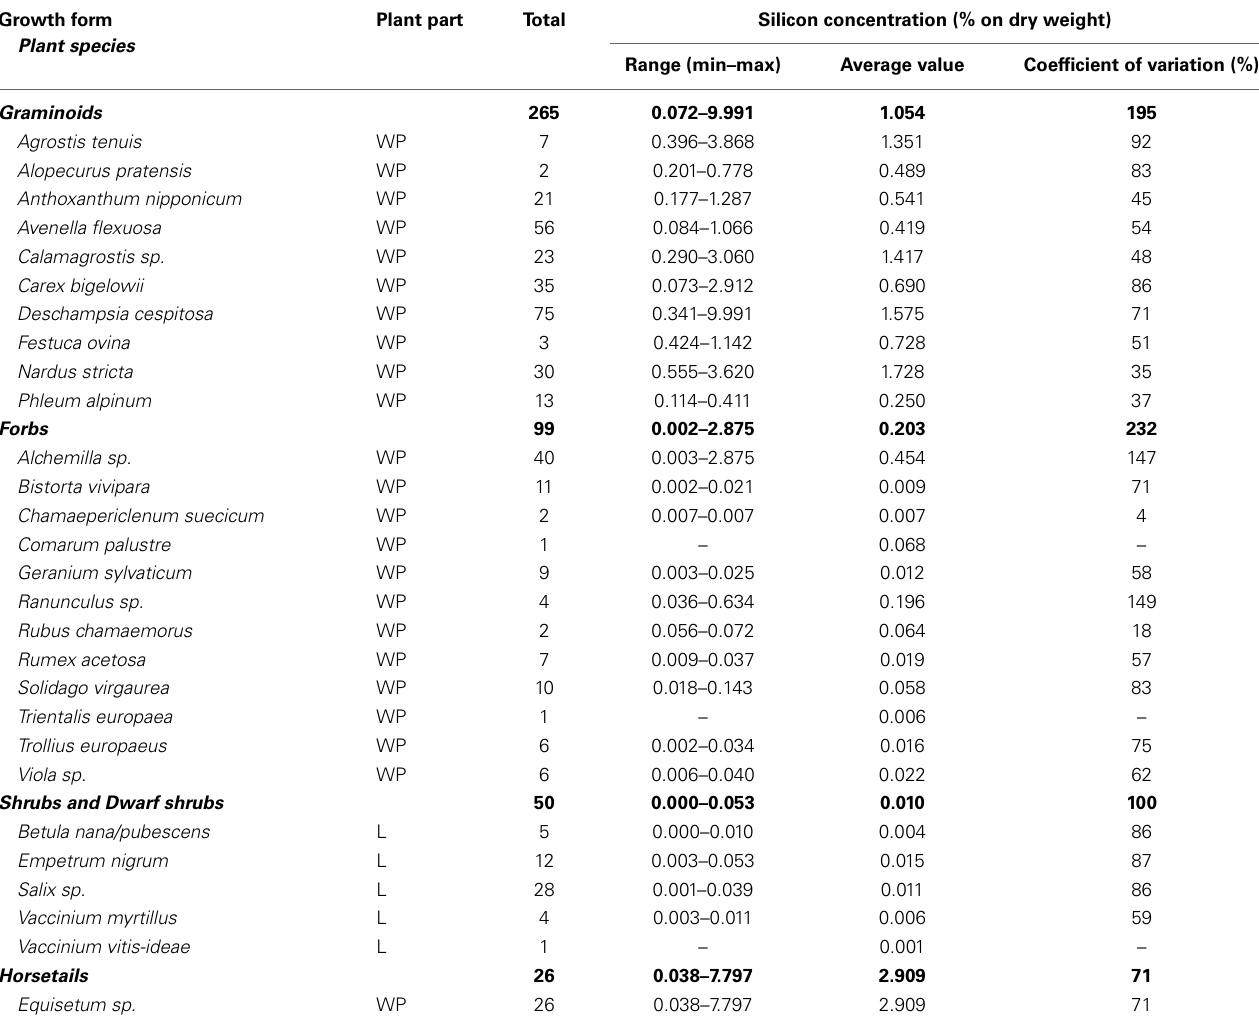
Table 1 | Overview of plant species, plant part, sample size ( n ), and the plant silicon concentration range, average value and the coefficient of variation of the plant silicon concentration for all studied growth forms with species alphabetically ordered within each growth